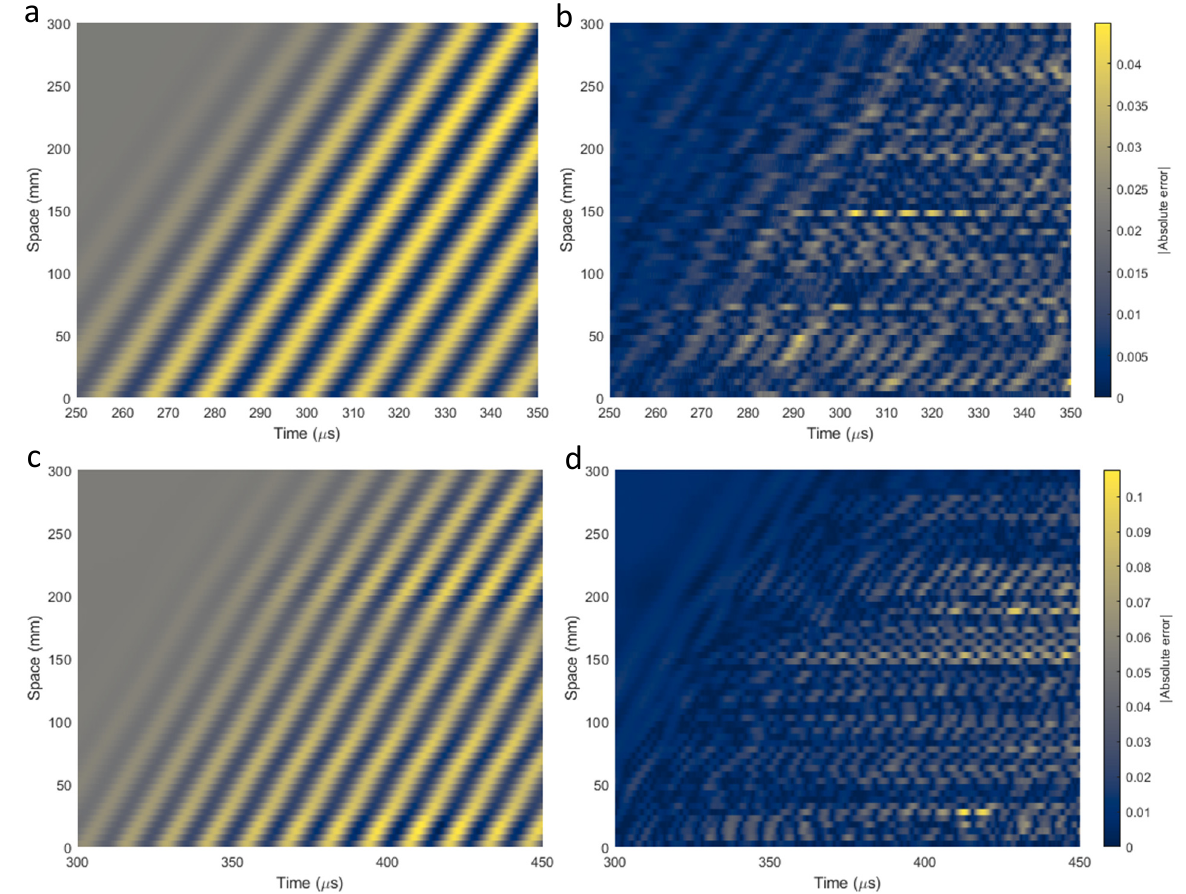
Figure 6. PINN prediction results: (a) relative displacement prediction for the glass sample, (b) absolute error between PINN results and measurement data for the glass sample, (c) relative displacement prediction for the mortar sample, and (d) absolute error between PINN results and measurement data for the mortar